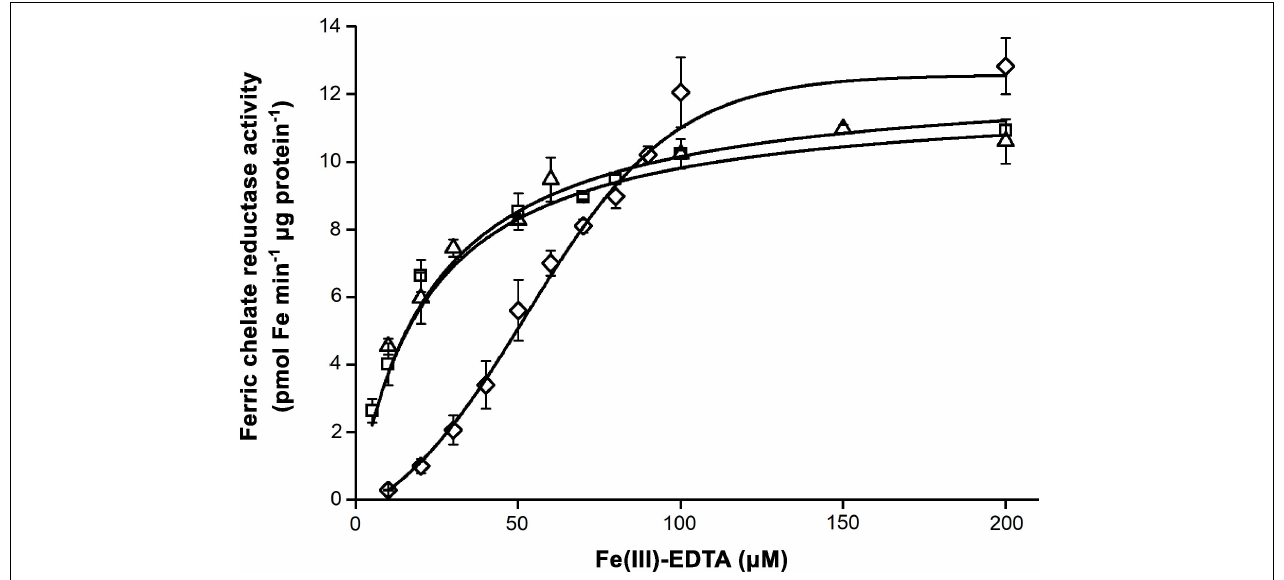
FIGURE 9 | Ferric chelate reductase (FCR) activity of chloroplast inner envelope (cIE) vesicle fractions isolated from leaves of Brassica napus grown under Fe deficient (dFe—triangle), optimal (oFe—square) and supraoptimal Fe supply (sFe—diamond). Boltzmann sigmoidal fit represents the saturation of the FCR activity. Error bars represent SD